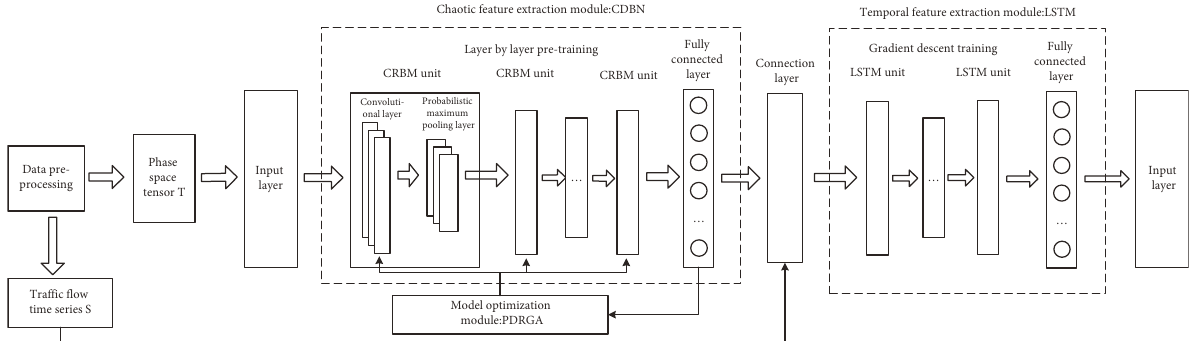
Figure 5: Structure diagram of the PDRGA-CDBN-LSTM hybrid